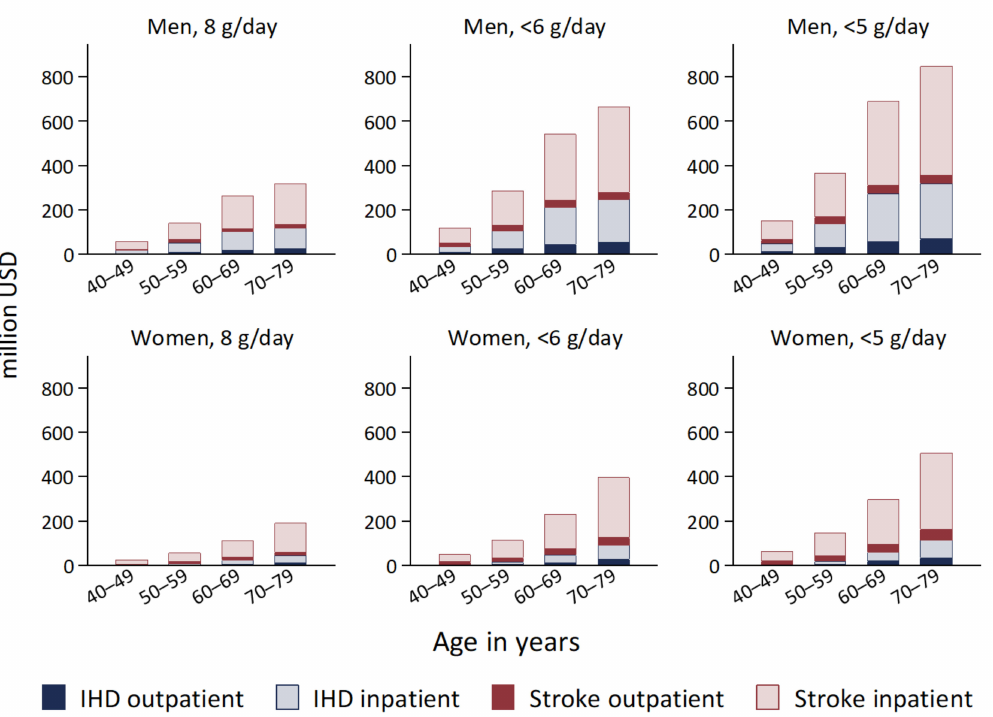
Figure 4. Projected cumulative total savings of national healthcare expenditures for IHD and stroke by reducing mean dietary salt intake to 8 g/day, <6 g/day, and <5 g/day between the years 2019 and 2029 compared with the base-case scenario in a closed cohort of population aged 40–79 years in 2019. IHD, ischemic heart